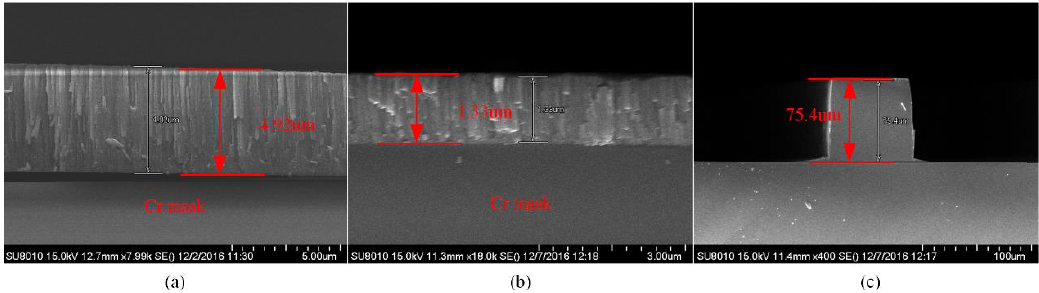
Figure 9. ( a ) SEM image of Ti mask before the etching; ( b ) SEM image of Ti mask after the etching; ( c ) SEM image of the etch profile with Ti mask.